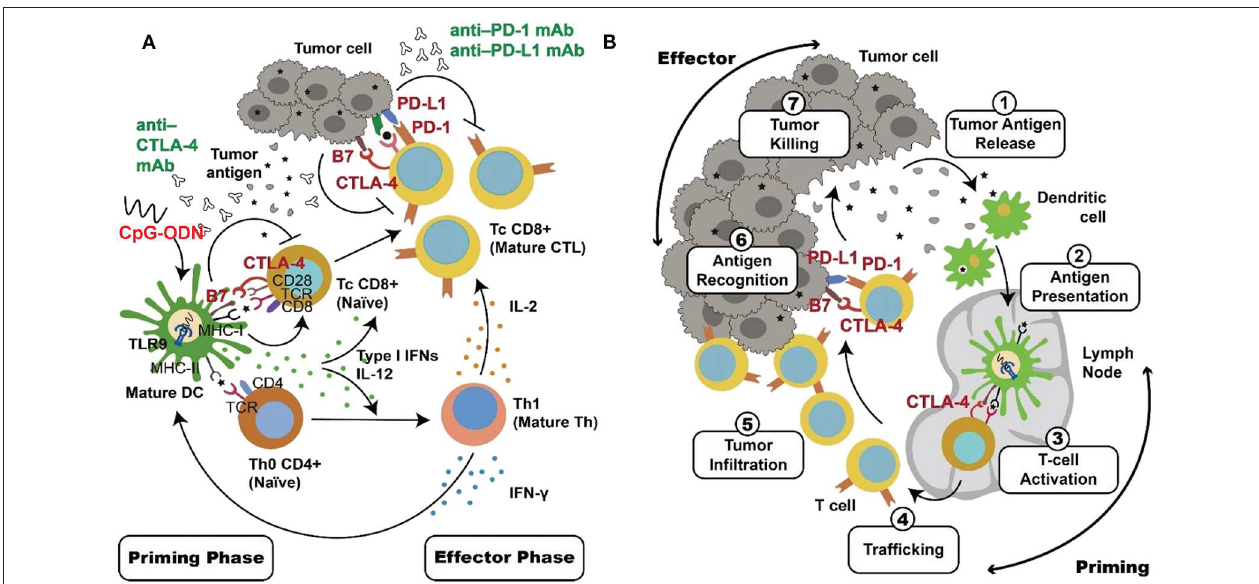
FIGURE 2 | Complementary mechanisms of TLR9 activation and checkpoint blockade in combinational cancer immunotherapy. DCs and T cells play key roles in the antitumor immune response. These two types of cells are major target for TLR9 agonists and immune checkpoint inhibitors, respectively. (A) Activation of TLR9 by CpG-ODN triggers innate immune responses, including cytokine production and the uptake and presentation of tumor antigen in DCs. These adjuvant effects, particularly the production of IL-12 and type I IFNs, facilitate a Th1 response of T cells and expansion of tumor-specific T cells during the priming phase. Immune checkpoint blockade by anti-PD-1/anti-PD-L1 antibody release inhibition of CD8 + cytotoxic T-cell activation during the effector phase. In contrast, anti-CTLA-4 inhibition activates T cells during both of the priming and effector phases. These events lead to a more effective and more specific adaptive immune response for tumor-cell killing. (B) DCs and T cells involved in the antitumor immune response serve different immunological functions in different locations, as